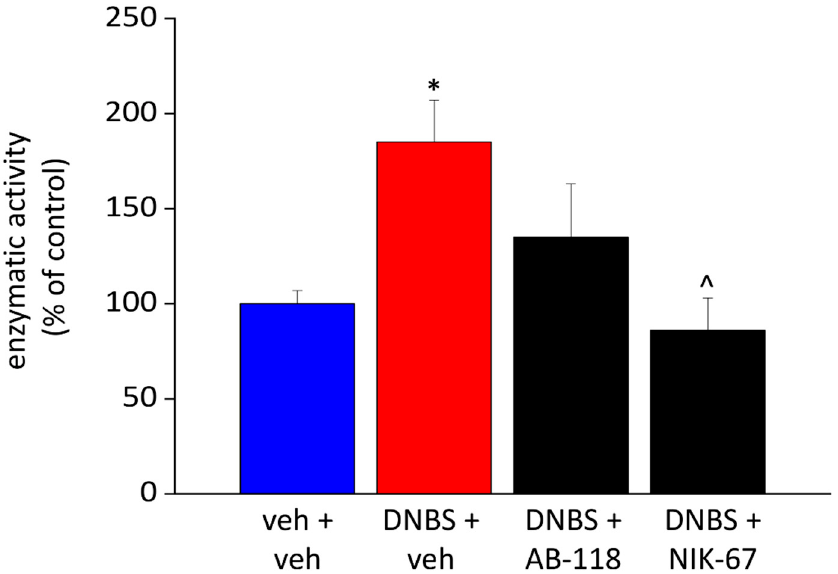
Figure 5. Effect of DNBS injection and AB-118 or NIK-67 repeated administration on colon CA IV activity. The CA IV enzymatic activity was assessed 15 days after DNBS injection by measuring the rate of the CO 2 hydration reaction catalysed by the treated extracts using an Applied Photophysics Stopped-Flow instrument. The enzymatic activity was expressed as percentage of controls. Each value is the mean ± S.E.M. and represents the mean of 5 rats per group. * p < 0.05 vs. vehicle + vehicle treated animals. ^ p < 0.05 vs. DNBS + vehicle treated animals.